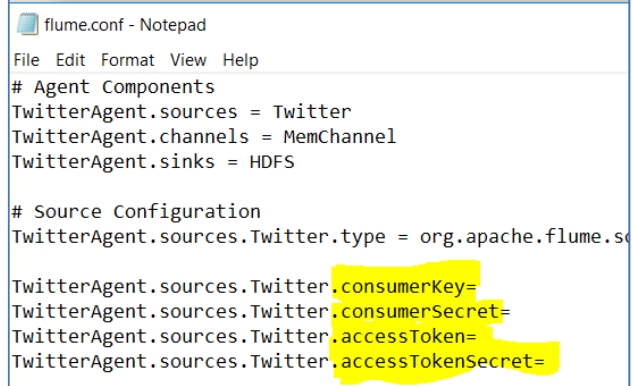
Figure 18. Configuration for data ingestion of Twitter messages.